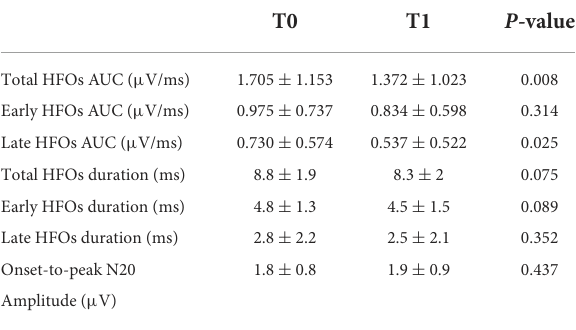
TABLE 1 HFOs and N20 values expressed as means ± standard